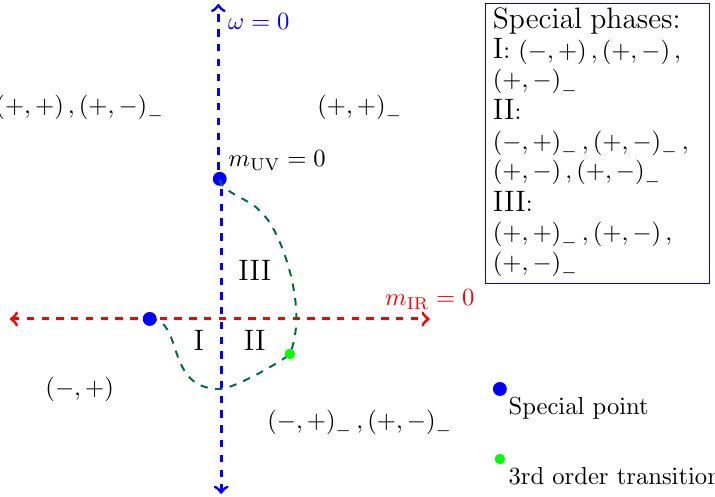
Figure 9. The conjectured (+ , − ) “special phases” in one scenario — q < 0 , δω